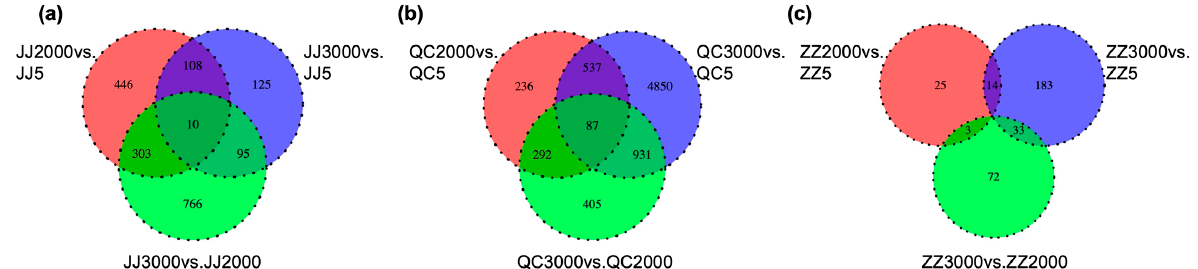
Figure 4. Venn diagram of differentially expressed genes (DEGs) in different comparisons. All DEGs are grouped into three comparison groups represented by three circles. The overlapping portions of the different circles represent the numbers of DEGs common to these comparison groups. ( a ) Venn diagram of grafted seedlings propagated from donors at different ages (5-, 2000-, and 3000-year-old) ( b ) Venn diagram of cutting seedlings propagated from donors at different ages (5-, 2000-, and 3000-year-old). ( c ) Venn diagram of sown seedlings propagated from donors at different ages (5-, 2000-, and 3000-year-old).